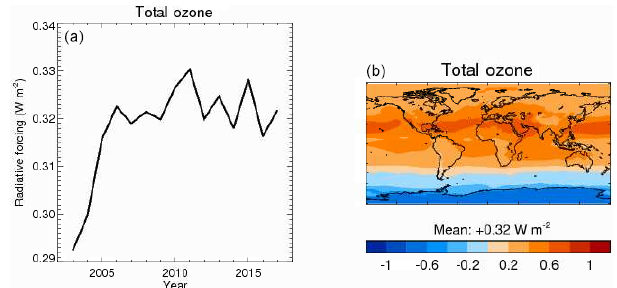
Figure 14. Annual and global-mean time series and average distri- bution for the CAMS reanalysis period (2003–2017) of the strato- spherically adjusted radiative forcing of ozone (relative to 1750 and in Wm − 2 ), calculated as the sum of tropospheric and stratospheric ozone radiative forcing. Radiative forcing is given for shortwave plus